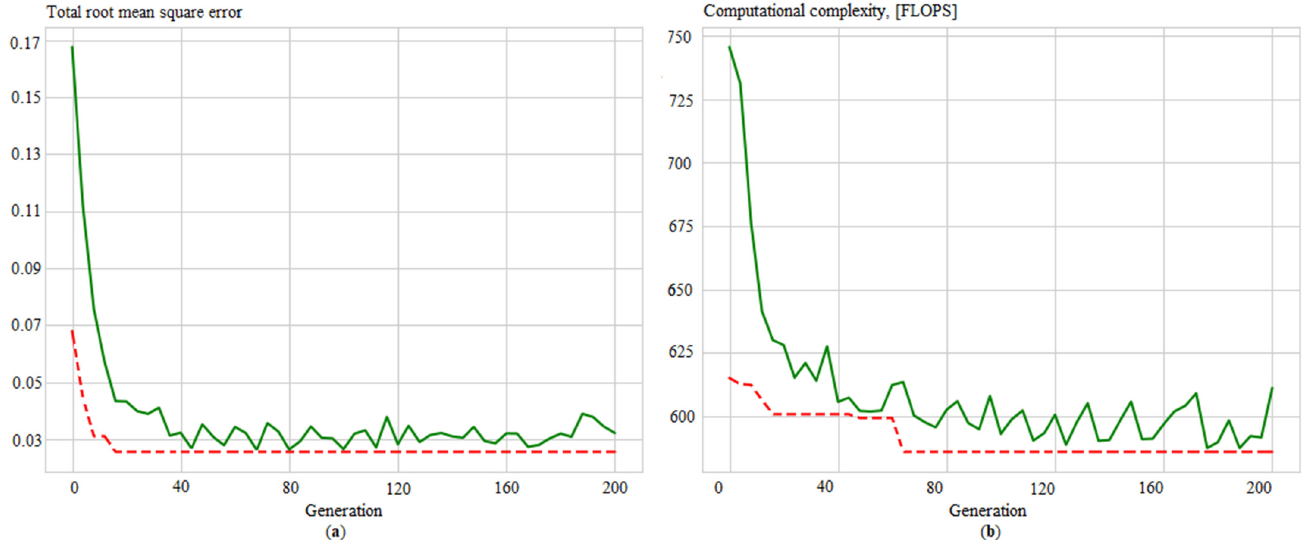
Figure 15. Evolution of the ANN control in the process of determining its best structure by: ( a ) total root mean square error; ( b ) computational complexity, where solid green lines are average values per generation, and dotted red lines are minimum values per generation.